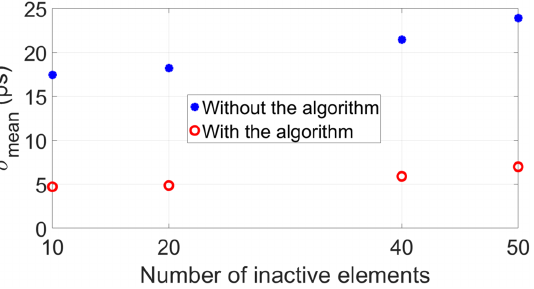
Figure 11. Mean value of the distributions of standard deviation shown in Figure 10b, which were obtained from measurement